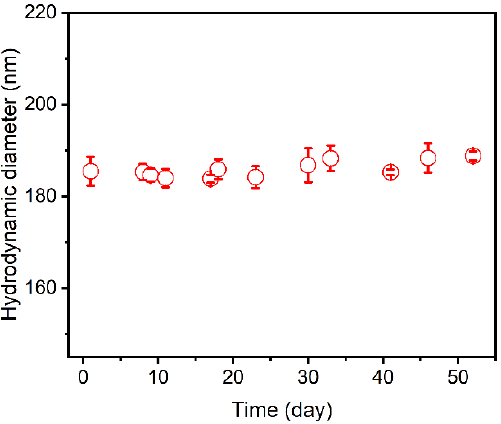
Figure 6. The time dependent size stability of Cur-loaded CS nanocomplex.